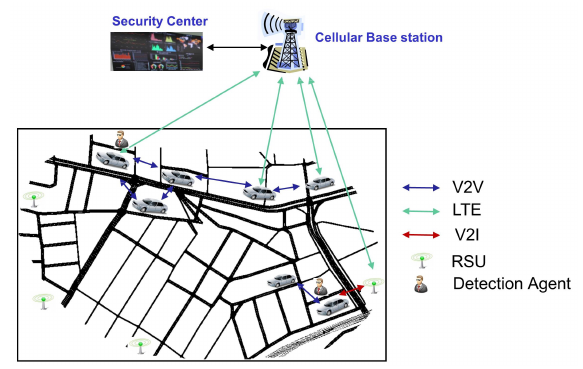
Figure 8. Intrusion detection